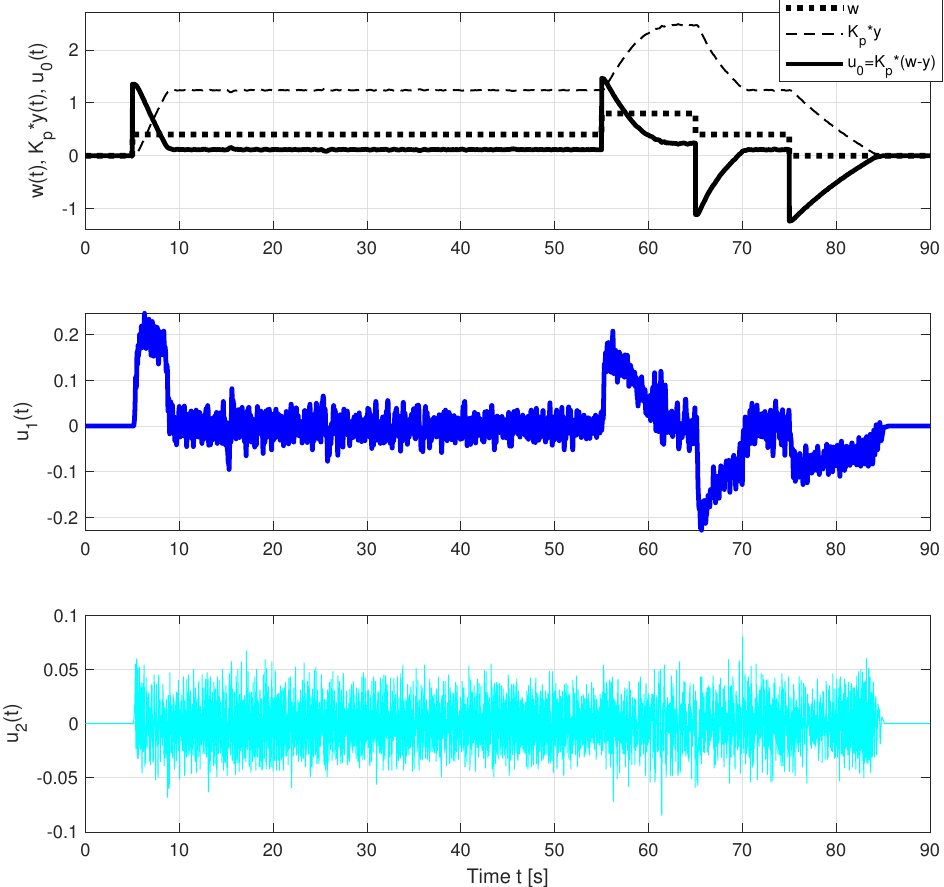
Figure 9. Individual control components of the PIDA controller corresponding to different control error derivatives and the transients according to Figure